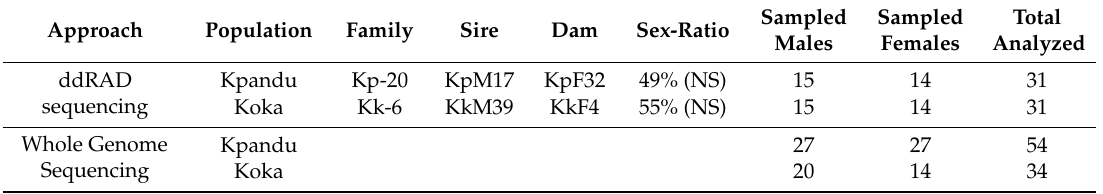
Table 1. Fish samples were used in this